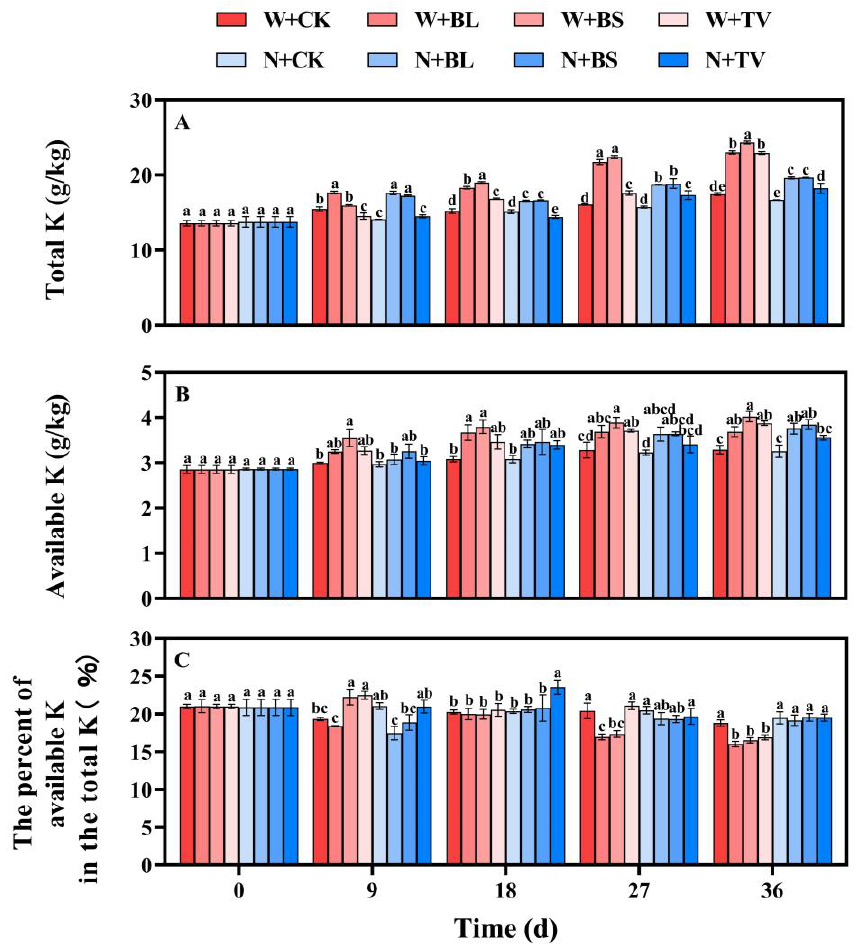
Figure 7. Changes in potassium concentrations in the treatments. Means ± SEs with different letters in each parameter indicate significant statistical differences ( p < 0.05). ( A ) Total K; ( B ) Available K; ( C ) The percentage of available K in the total K.